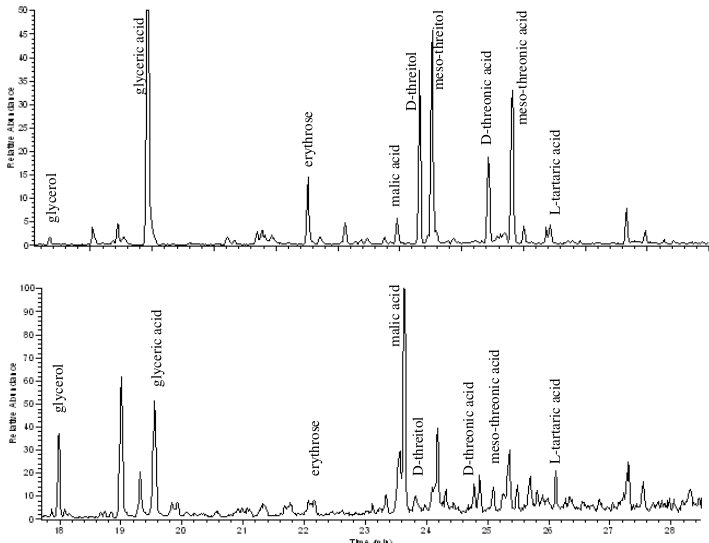
Figure 7. Extracted ion gas chromatograms of organic extracts as BSTFA derivatives from (top) an irradiated 1,3-butadiene/NOx/air mixture and (bottom) Bakersfield, CA, USA, PM 2 . 5 . Extracted ions are 103, 189, 217, 247, 335, 395, and 423.